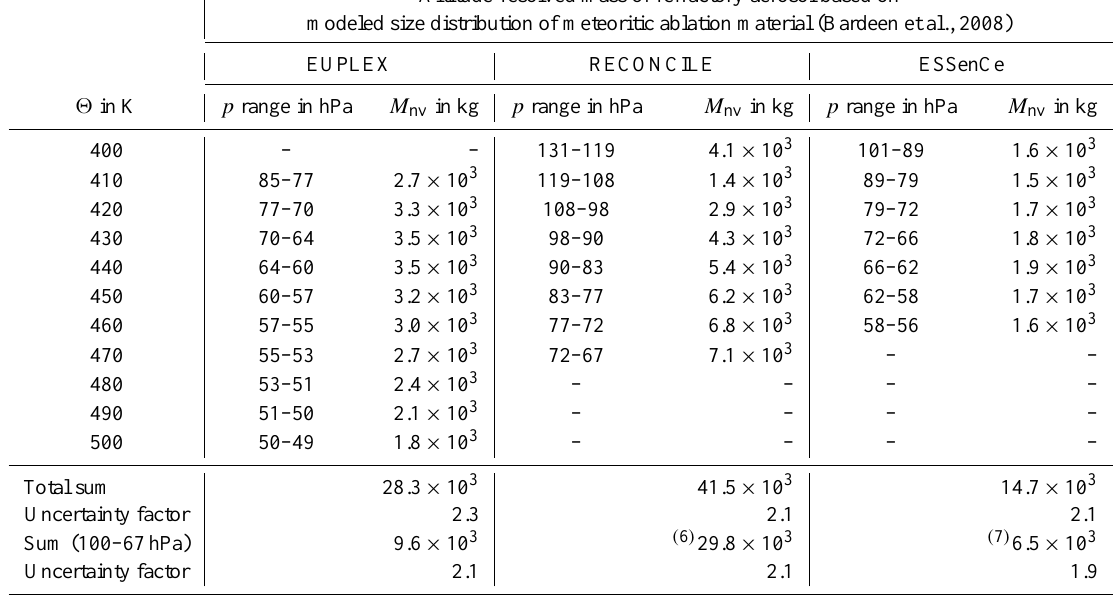
Table 4. Lowermost boundary for the estimates of the integrated refractory aerosol mass M nv in the vortex. Assumptions are the same as for previous calculation (cf. Sect. 6), as are the averaged vortex cross section areas from CLaMS as a function of (cid:50) . This mass estimate is determined by a size distribution of meteoritic ablation material only over the winter pole resulting from numerical studies (Bardeen et al., q M max nv /M min nv ) are applied to cover the extremes of the 2008). Vertical coordinates are given as provided in Table 2. Uncertainty factors of ( involved uncertainties. Indices ( ∗ ) simplify the traceability of the data’s origin in the text. Altitude-resolved mass of refractory aerosol based on modeled size distribution of meteoritic ablation material (Bardeen et al., 2008) EUPLEX RECONCILE